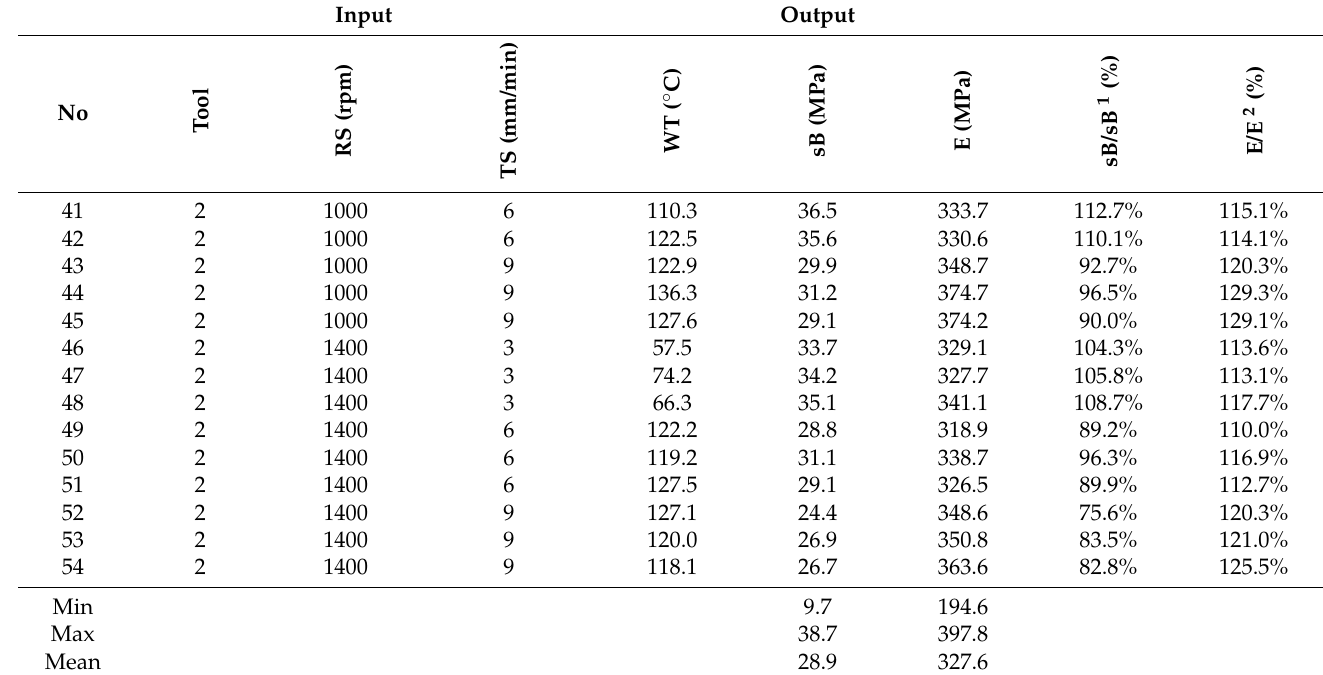
Figure 12. Interaction chart: Tool, RS, and TS vs. E.